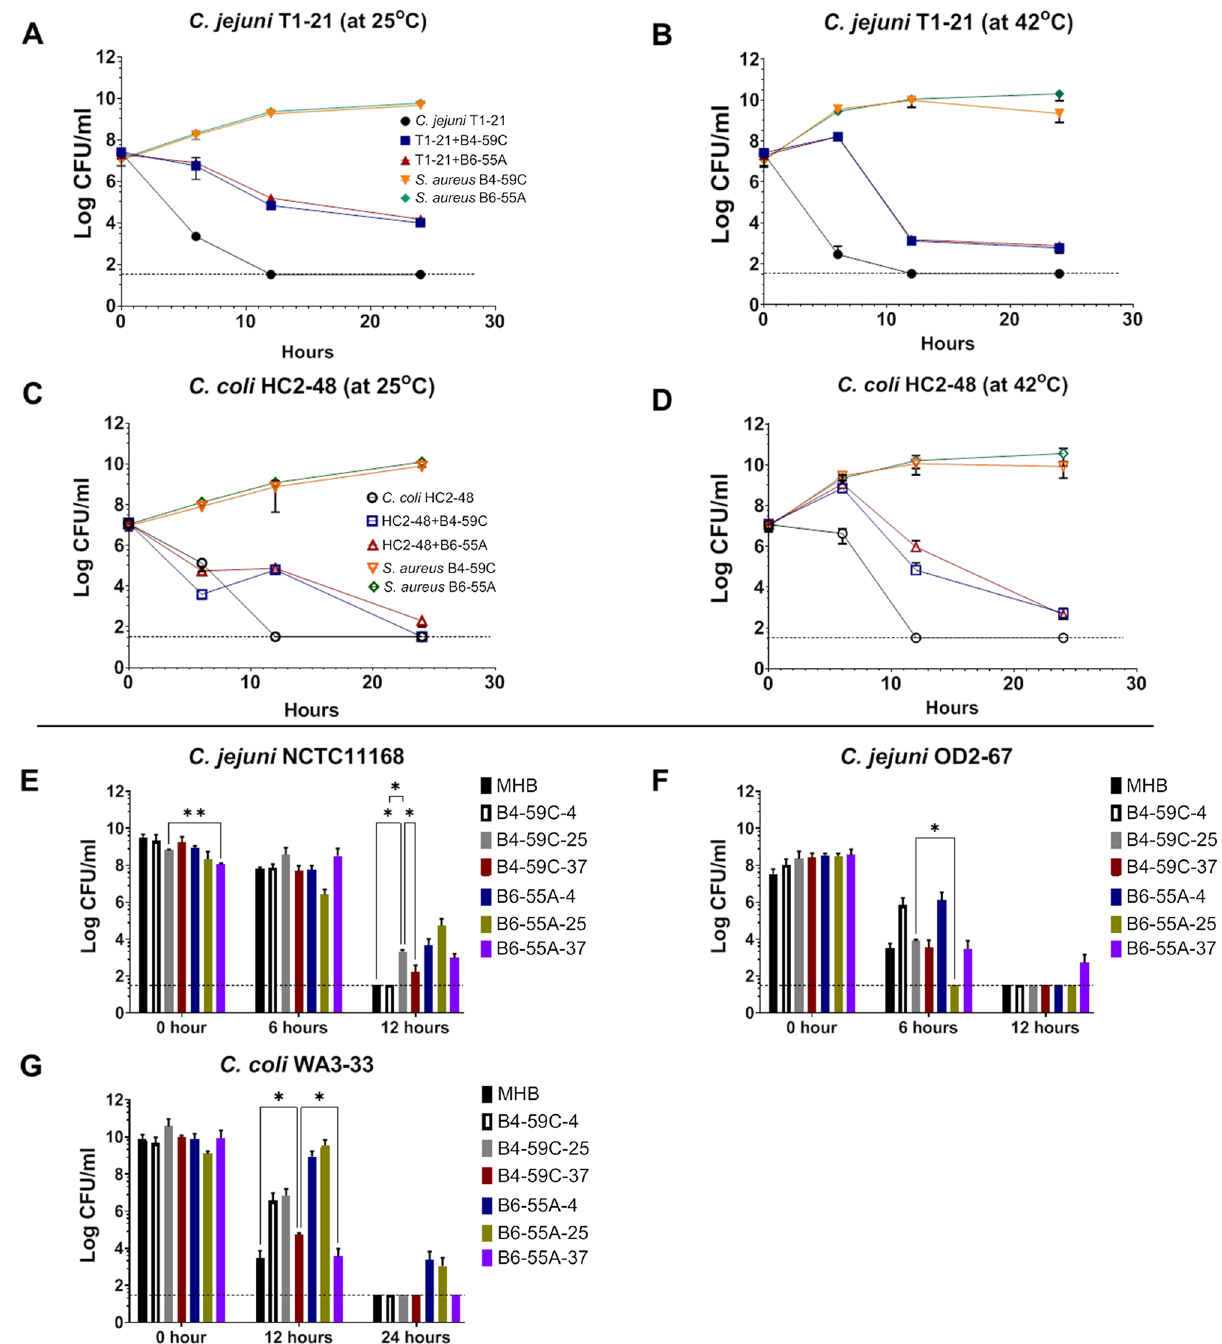
Figure 2. Aerotolerance of Campylobacter in mono or mixed cultures containing S. aureus strains or cell-free extracts. ( A – D ), Survival of C. jejuni T1-21 and C. coli HC2-48 in mono and mixed cultures of S. aureus B4-59C and B6-55A incubated at 25 °C and 42 °C with aerobic conditions. ( E ) Survival of C. jejuni NCTC11168, ( F ) C. jejuni OD2-67, and ( G ) C. coli WA3-33 in media containing cell-free extracts of S. aureus at 42 °C with aerobic conditions. The S. aureus cell-free extracts listed in the Fig. 1 legend were used in this experiment. Campylobacter cells grown in non-amended MHB served as a control. Mean values of CFU counts with SD error bars are represented in figures. Horizontal dotted lines in the figures represent the limit of detection for colony counts (LOD, ~ 33 CFU/ml) in these assays. All data points plotted on the LOD line in figure ( A – D ) and all the bars not exceeding LOD line in figures ( E – G ) represent the readings for the respective time points with no detectable CFU counts. Two-way ANOVA with repeated measures (Tukey multiple comparison tests) was conducted in GraphPad Prism 9: * p < 0.05, ** p < 0.01, *** p < 0.001, **** p <